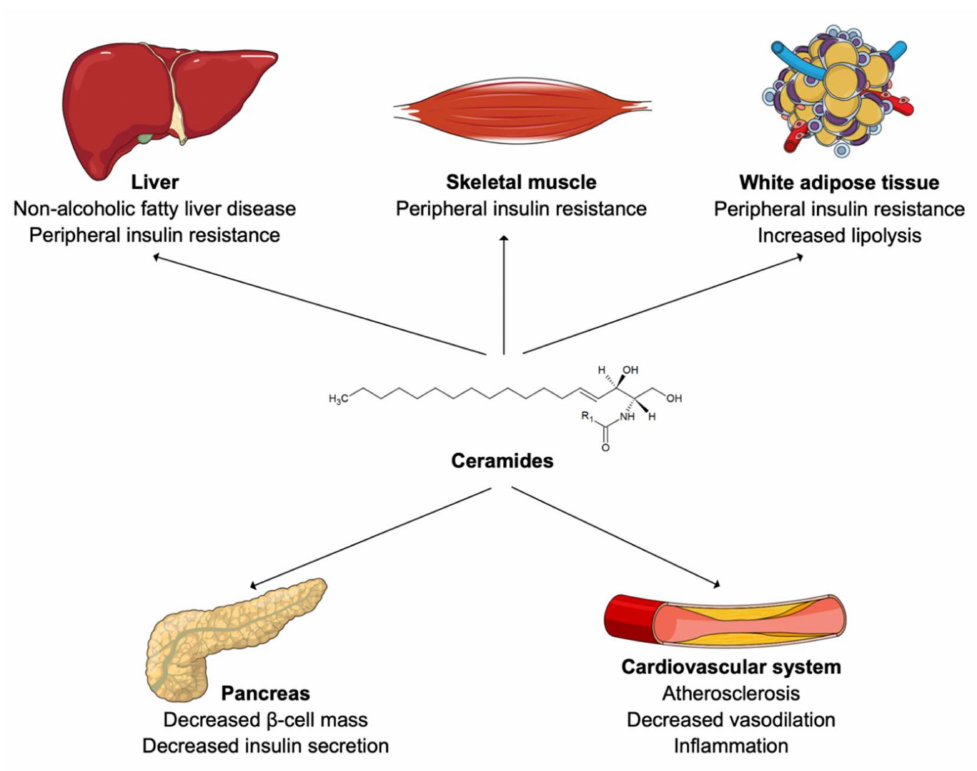
Figure 2. Ceramides in human cardiometabolic